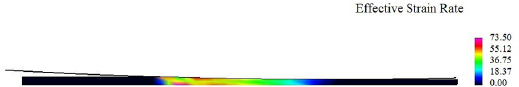
Figure 5. Effective strain rate - thickness of 1.0 mm, velocity of 250.00 mm/s and reduction of 30% (simulation 4).